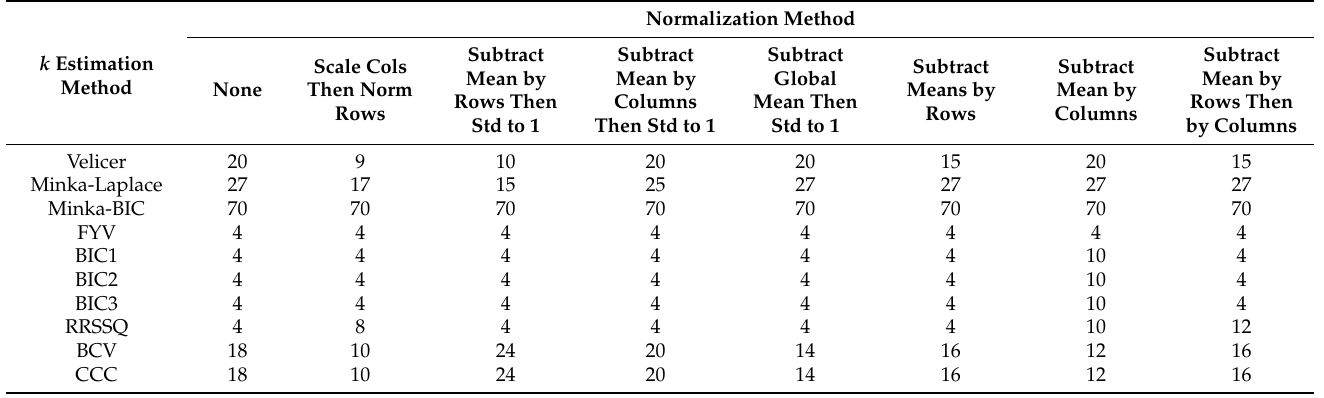
Table 1. This table shows the estimates of k for eight normalization methods (columns) using ten methods (rows).